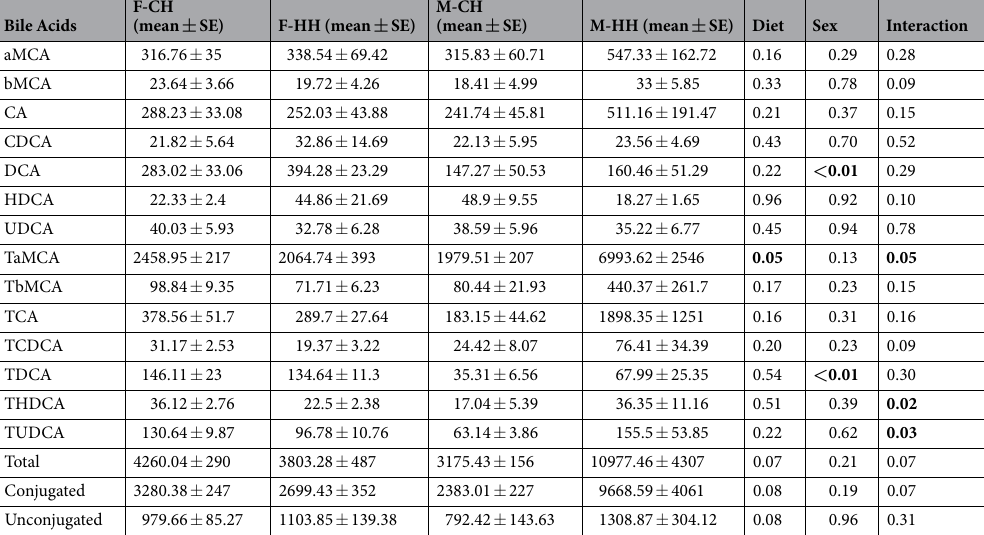
Table 2. Serum bile acids in male and female offspring from control and HFD-fed